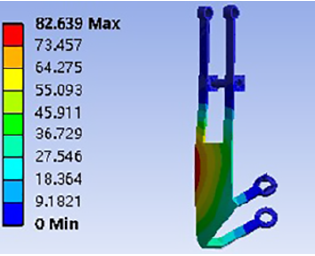
Figure 11. The first-order mode shape of the clamping arm (Hz).